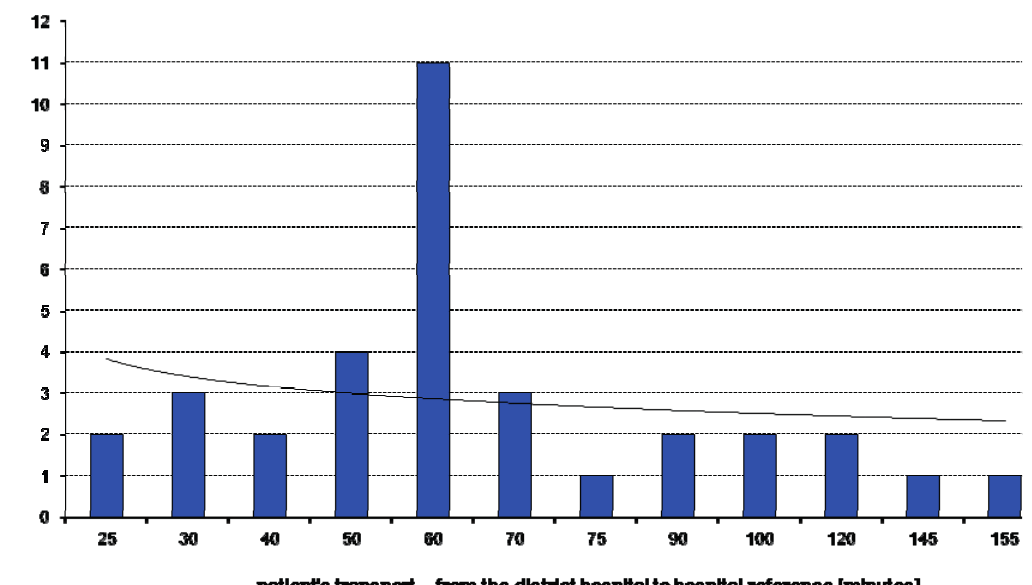
Figure 4. Transportation time of patients with acute coronary syndrome from the district hospital to the referral hospital (stage II transport). Patients’ transportation times from the district hospital to the referral hospital (two—stage transport) ranged from 25 min to 155 min. Average time to the two-stage reference center was about 67 min.